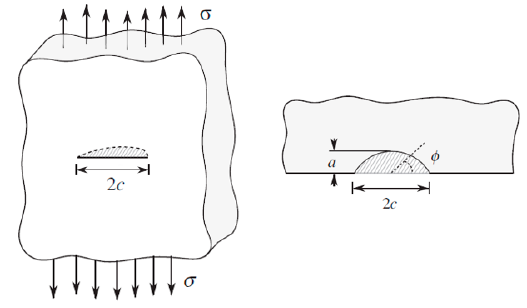
Figure 2. Representation of an elliptical surface flaw [13].